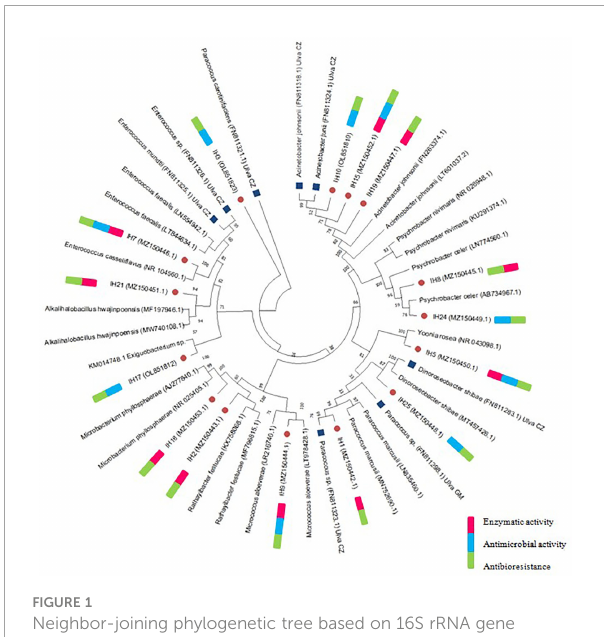
FIGURE 1 Neighbor-joining phylogenetic tree based on 16S rRNA gene sequences and different enzymatic and antimicrobial activities in comparison with isolates of Ulva rigida from Ismail et al. (2018): associated bacteria isolated from Ulva ohnoi (red spots) and Ulva rigida -associated bacteria (blue squares).